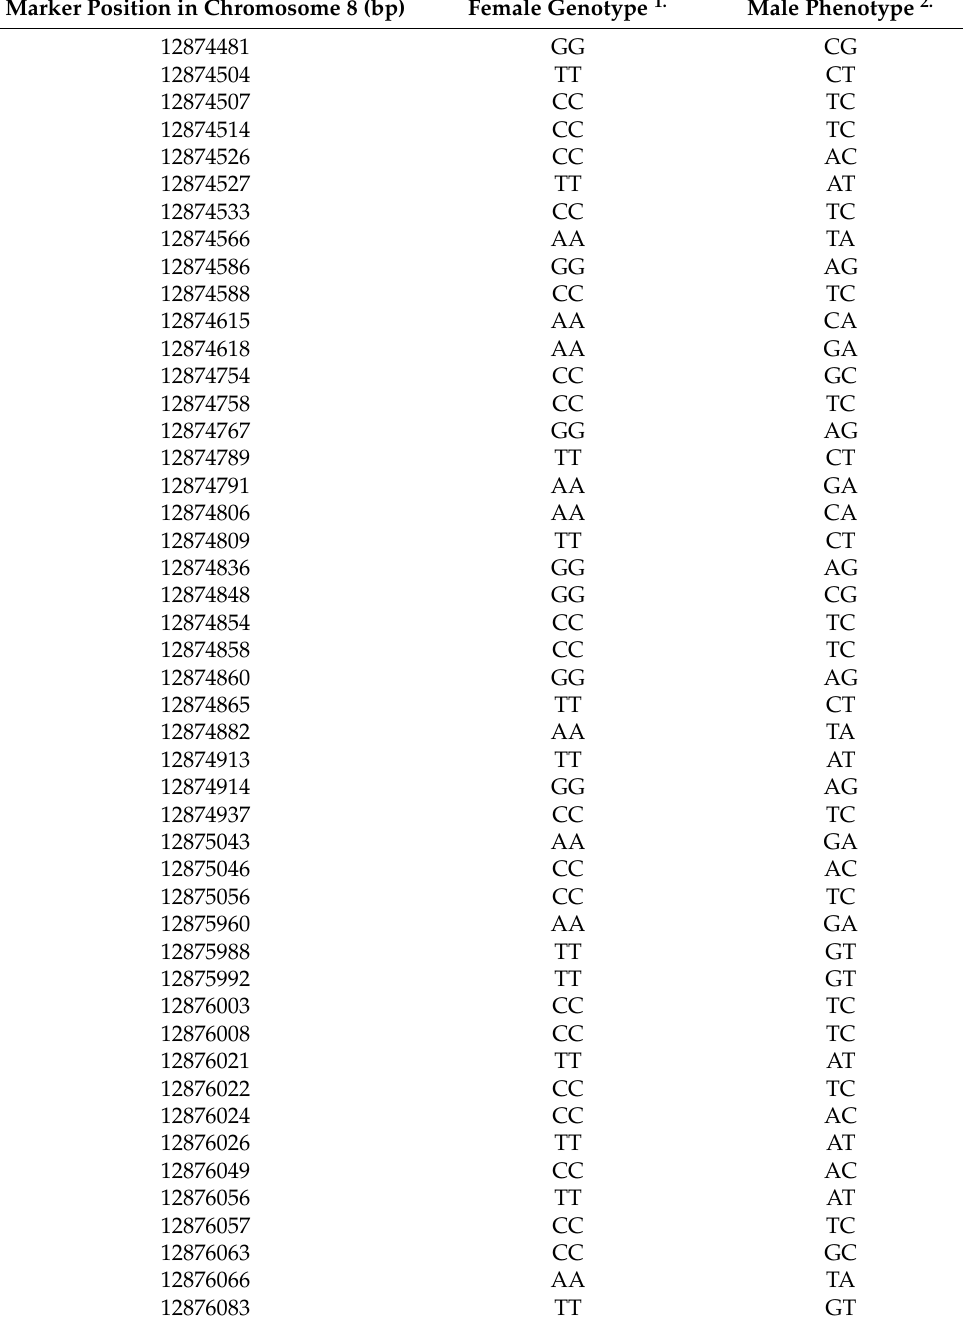
Table 4. SNPs located in the Anti-Mullerian Hormone gene ( amh ) for which male and female Muskellunge show distinct